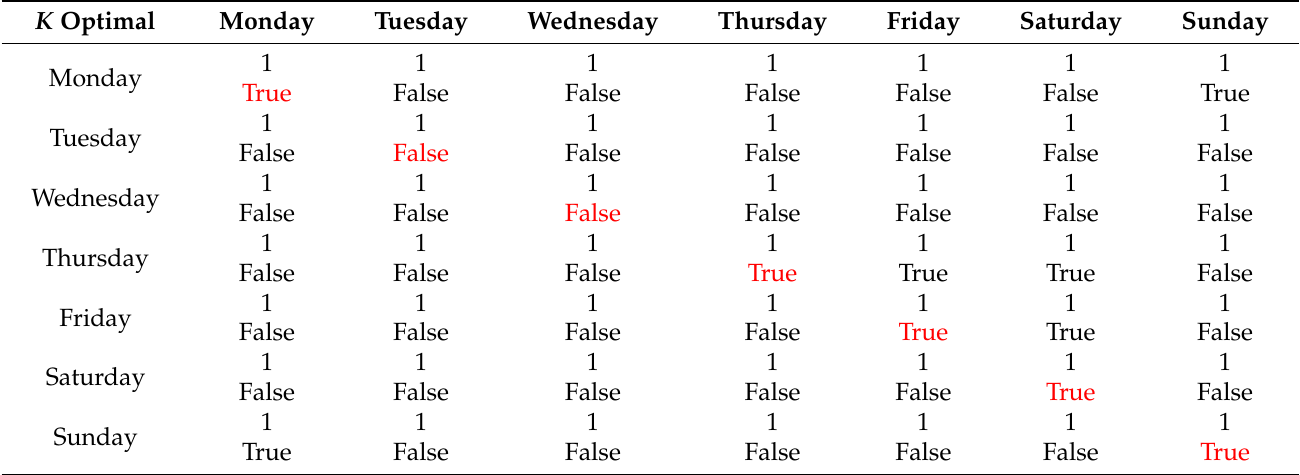
Table 4. F-causality tests between temperature and electricity demand with an optimal parameter. K Optimal